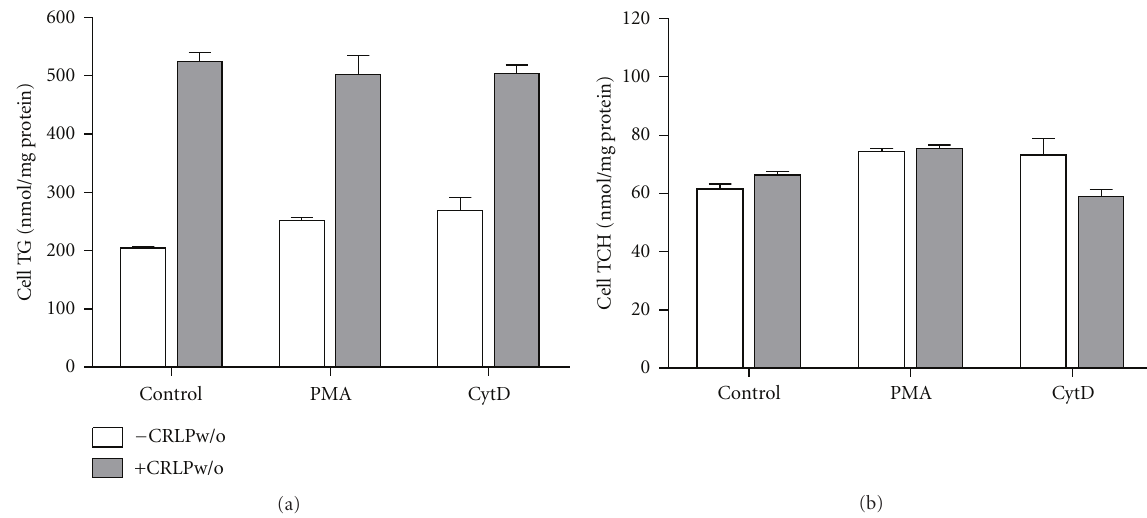
Figure 3: E ff ect of cytochalasin D and PMA on macrophage lipid accumulation. HMDM were incubated 24h with 80 μ g cholesterol/mL CRLPw/o or without CRLPw/o in the presence of 2 μ g/mL cytochalasin D (CytD) , or 1 μ g/mL PMA both dissolved in DMSO or DMSO alone (control). Macrophage triacylglycerol (TG) and total cholesterol (TCH) content (nmol lipid/mg protein) were determined by fluorimetric assay (mean ± SD, n =